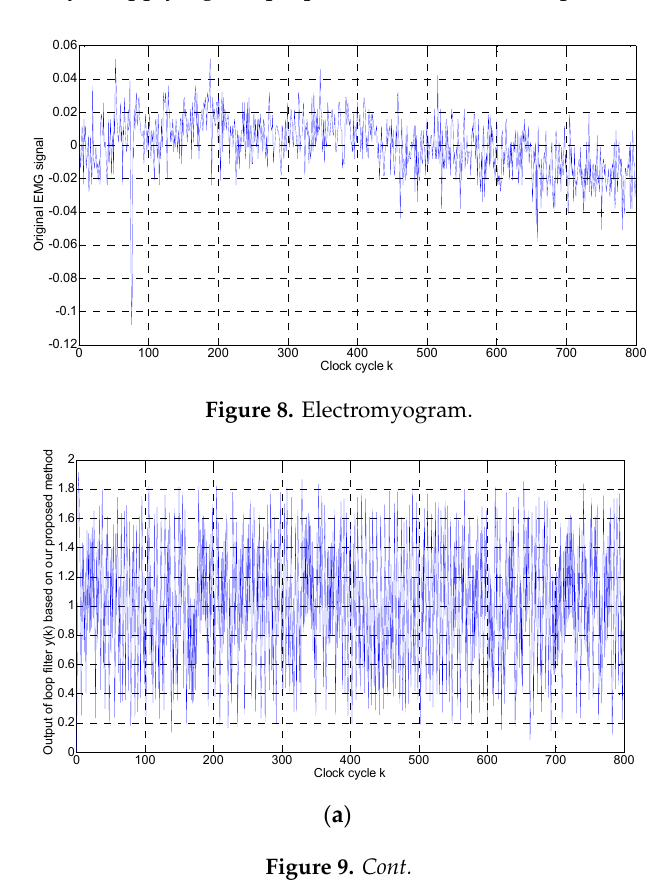
Figure 9. ( a ) Output of the loop filter under our proposed control strategy when the input is an electromyogram. ( b ) Output of the loop filter under the clipping control strategy [7] when the input is an electromyogram. ( c ) Magnitude response of the output of the loop filter under our proposed control strategy when the input is an electromyogram. ( d ) Magnitude response of the output of the loop filter under the clipping control strategy [7] when the input is an electromyogram.